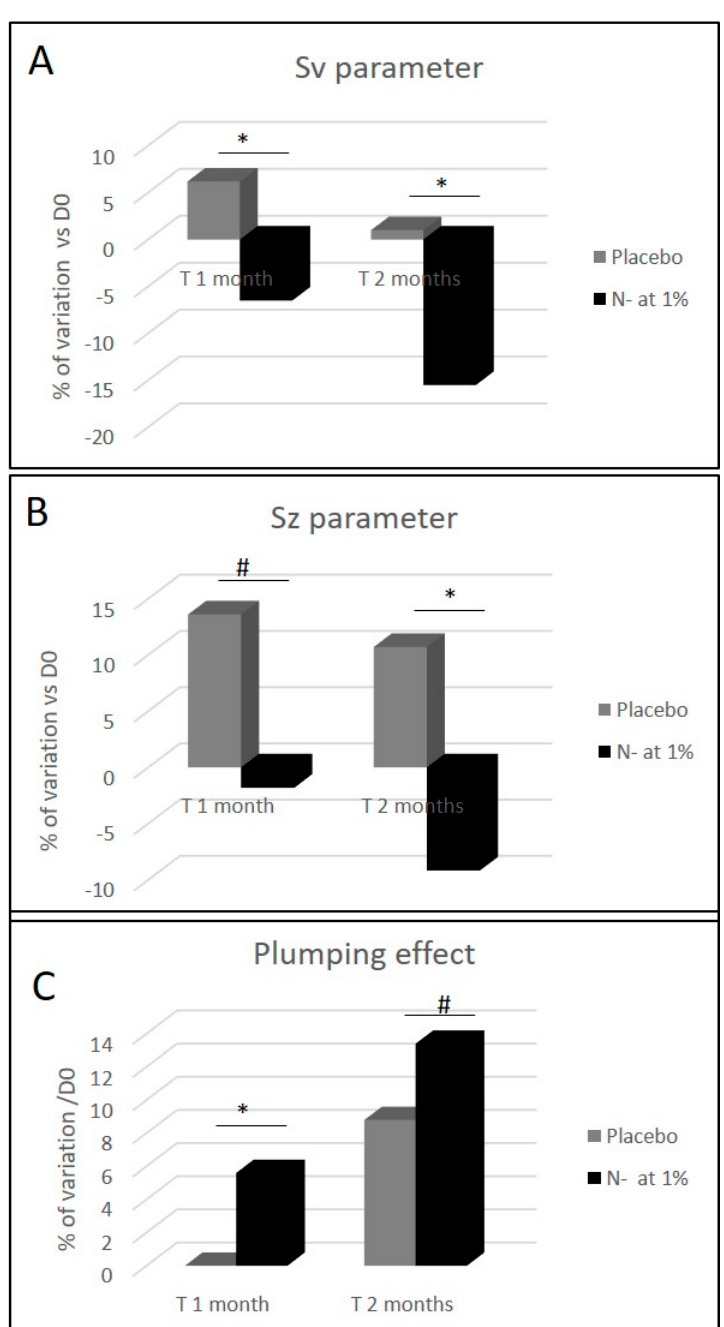
Figure 7. Clinical measurement of skin wrinkles depth (Sv parameter), skin smoothness (Sz parameter) and skin plumping effect before and after 1 and 2 months of a cosmetic cream application containing either placebo or N- root extract (1%) on the face. Sv and Sz parameters determined with C-cube and skin plumping effect, were reported through the use of a grading scale. The scale range varies from 0 (sagging, skin not firm) to 10 (tonic, firm and plumped skin). The measurements were done on the crow’s feet area. (* p < 0.05, and # p < 0.1).